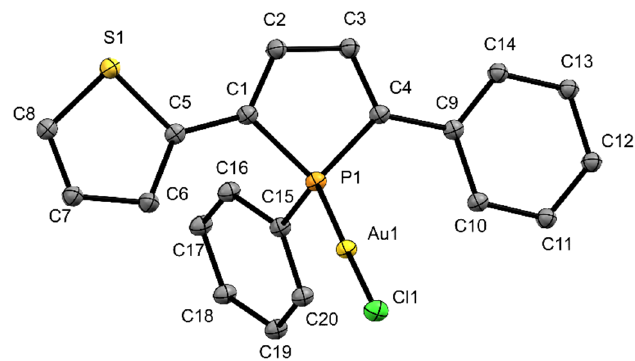
Figure 4. Ortep plots of the molecular structure of 5 in the solid state with ellipsoids drawn at the 30% probability level. Labels for hydrogen atoms and disorders are omitted for clarity. Important bond lengths and angles: (C1)–(C5) 1.431(14) Å, (C4)–(C9) 1.461(15) Å, (C1)–(C2) 1.328(15) Å, (C2)–(C3)